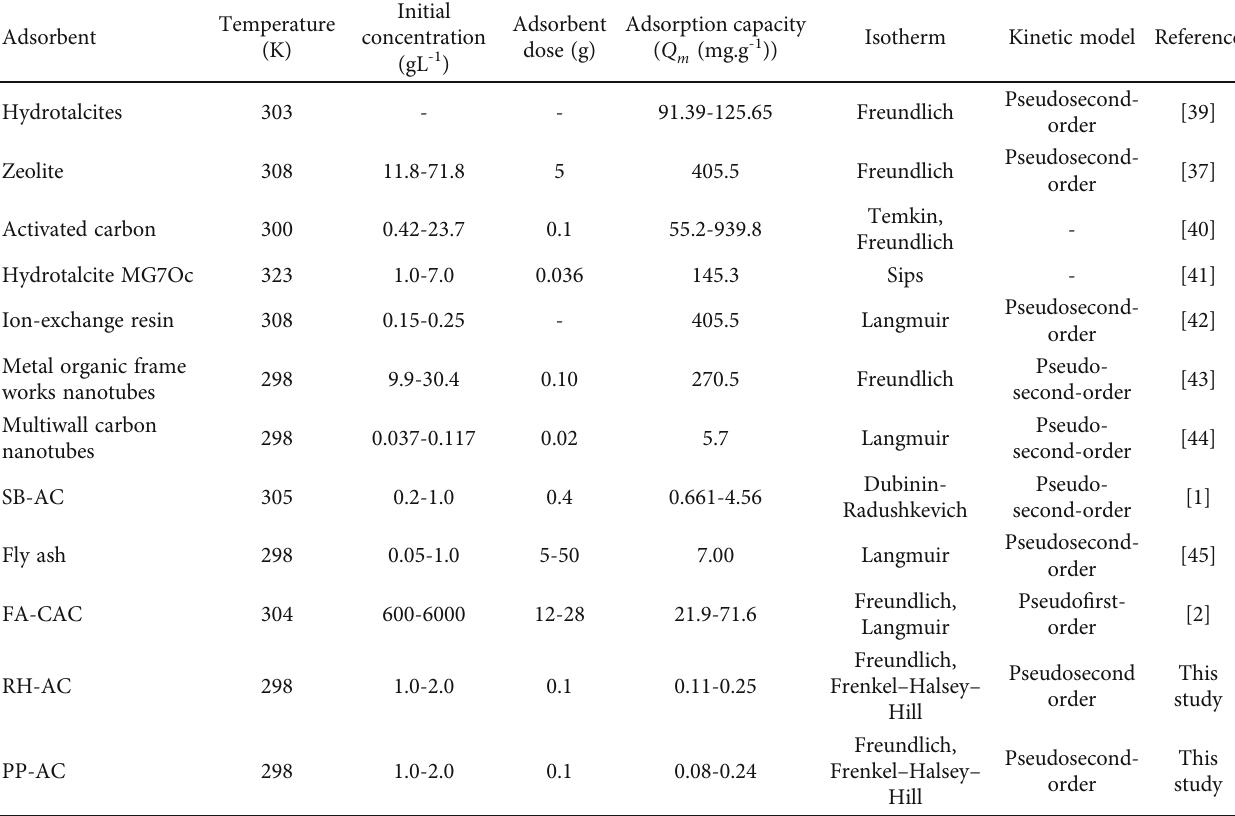
Table 2: Comparison of acetic acid adsorption on various adsorbent